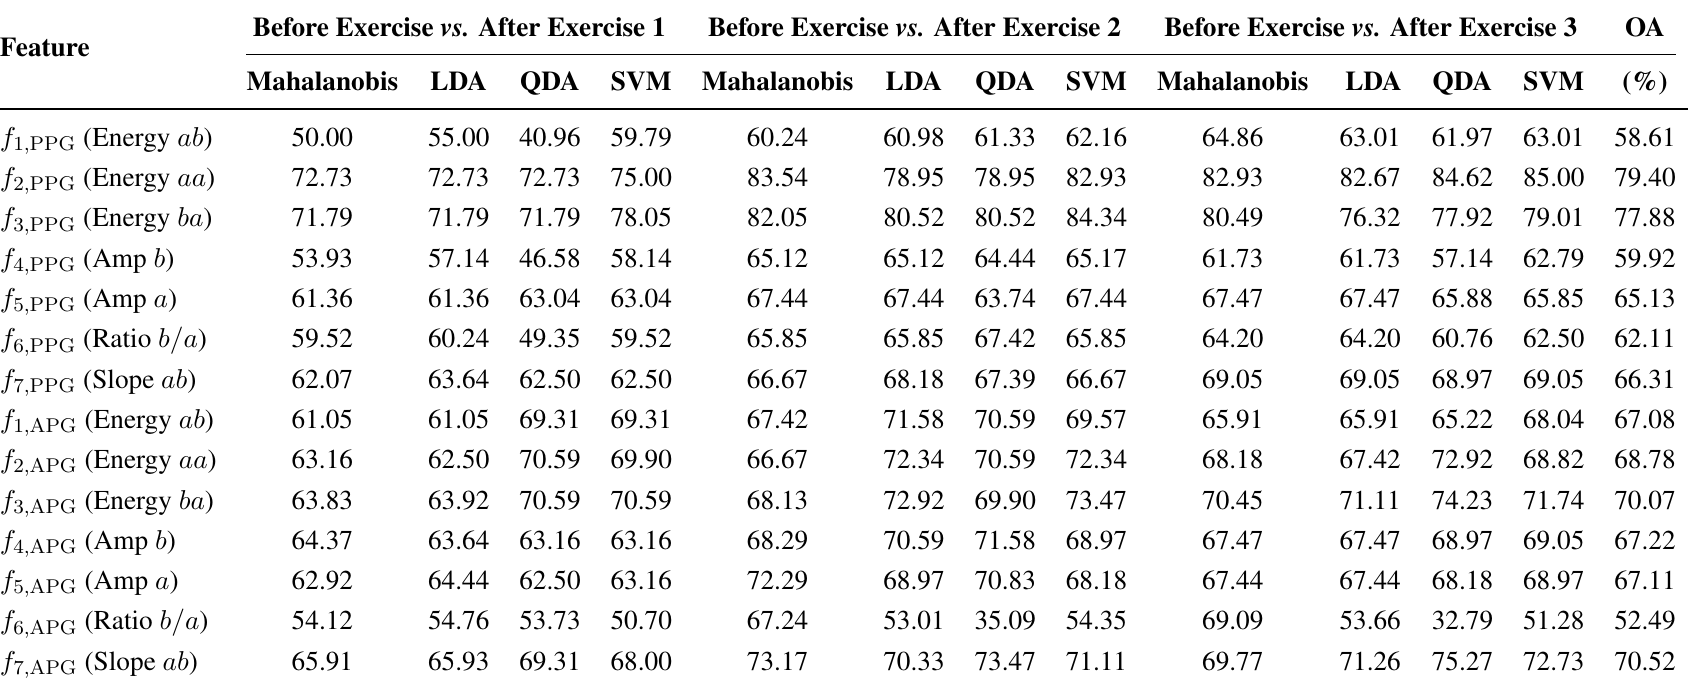
Table 3. Leave-one-out heat stress classification performance on PPG-chemical, biological and radiological (CBR) responders in the tropical condition